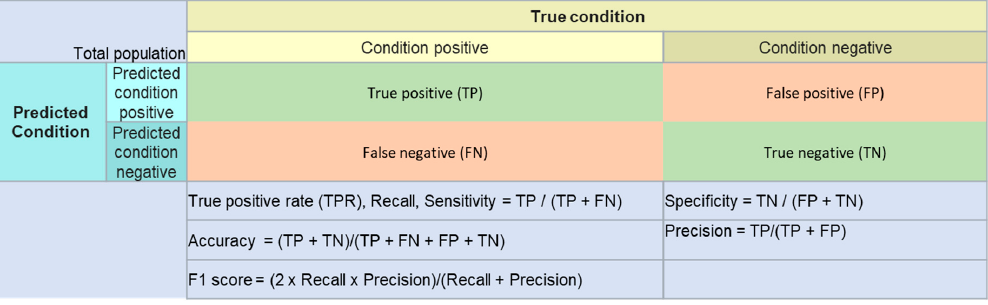
Figure 3. Performance measures and definitions.